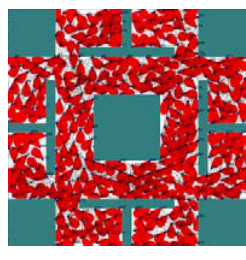
Figure 12. The sensing areas of Type 2 sensor nodes deployed by different algorithms in Case 1.